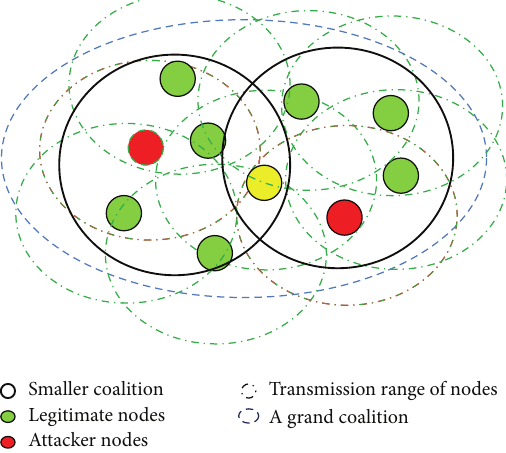
Figure 2: A coalition of ten (10) nodes with two (2)